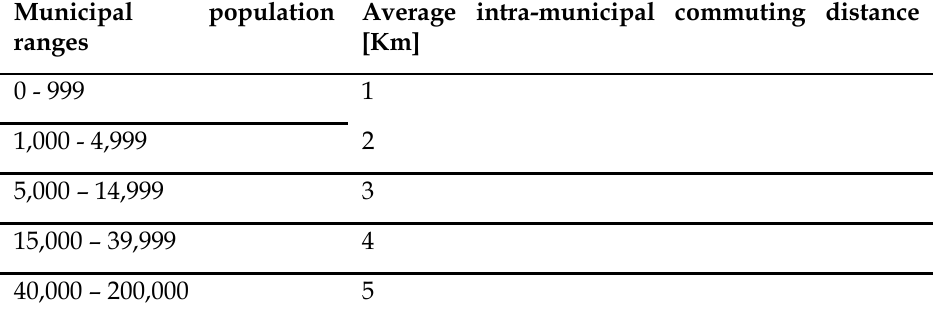
Table 2. Intra-municipal commuting distance versus population of Sardinian